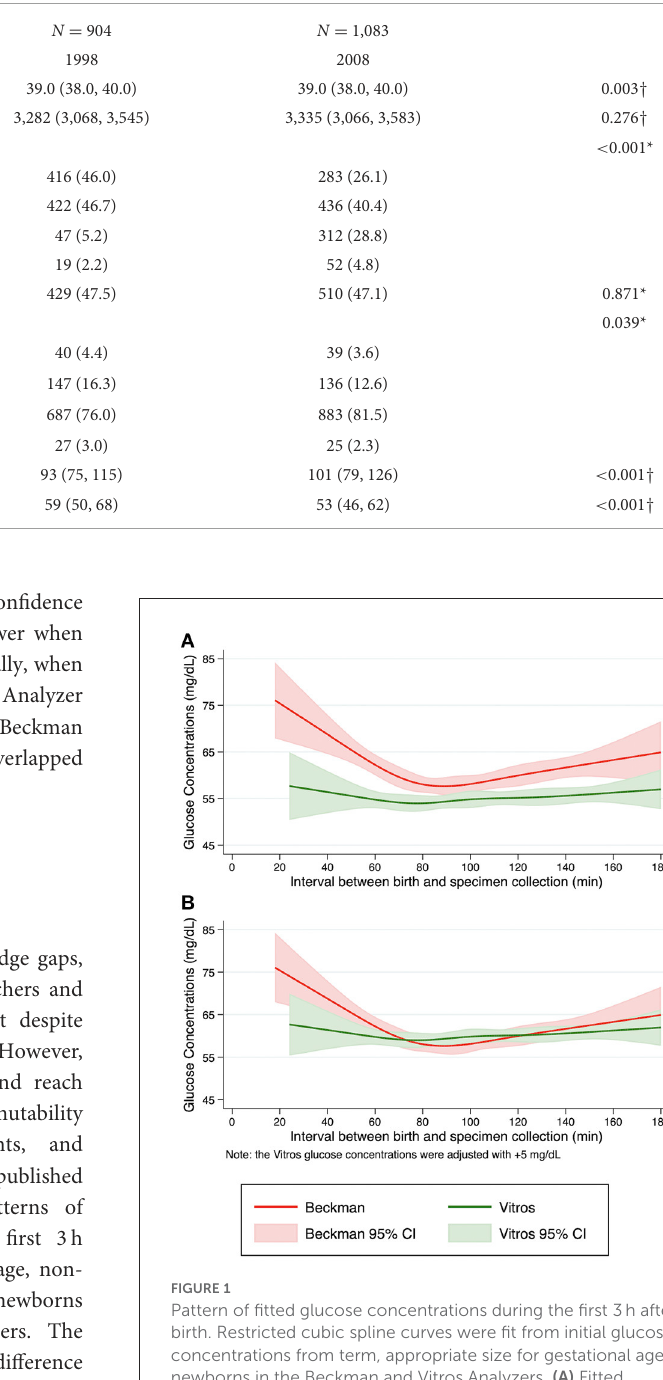
TABLE 1 Demographic and birth characteristics of term newborns who had plasma glucose concentrations measured by Beckman vs. Vitros analyzers. Characteristics Beckman Vitros